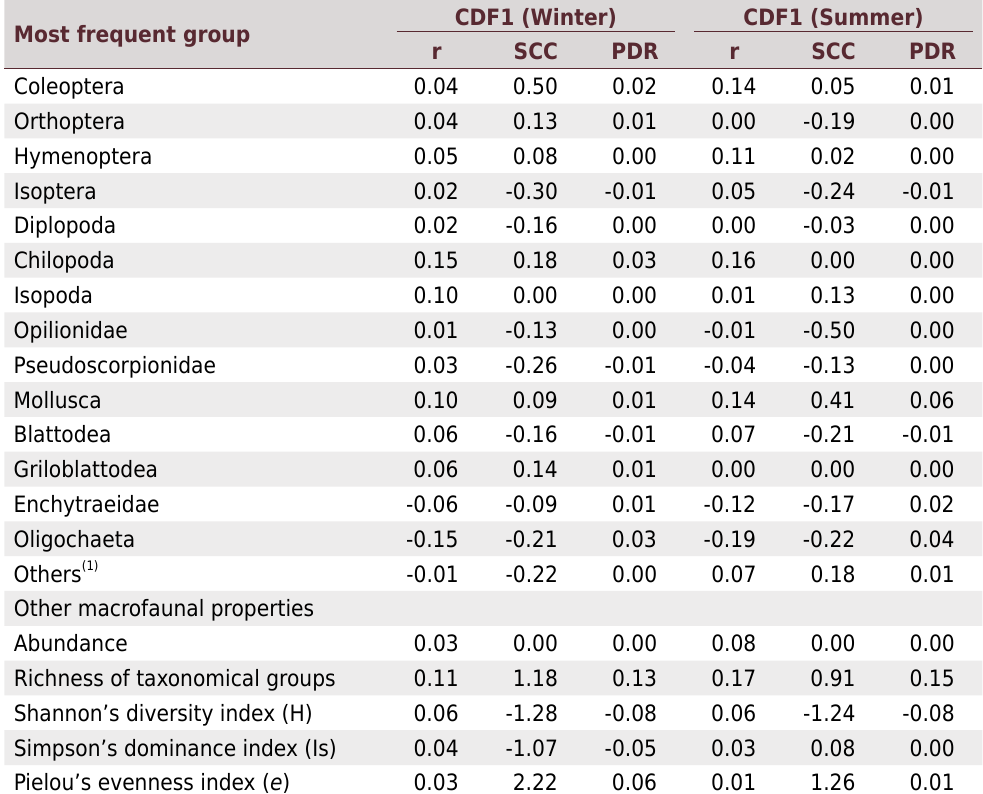
Table 2. Standardized canonical coefficients (SCC), canonical correlation (r), and Parallel Discrimination Rate (PDR: r × SCC) related to canonical discriminant analysis (CDA) containing macrofaunal variables, in winter and summer, regardless of the site